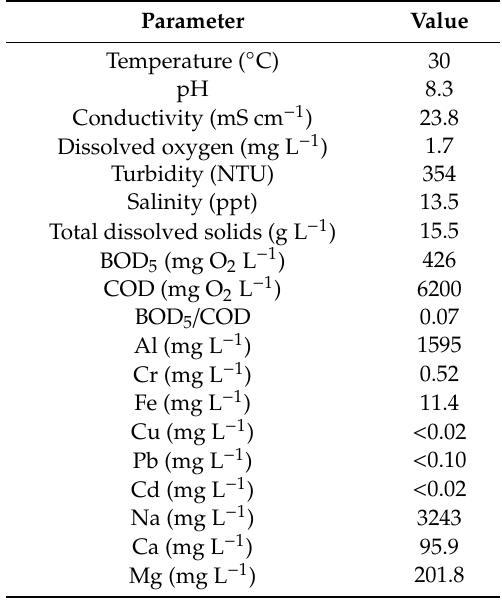
Figure 1. Ubication of the municipal sanitary landfill. Table 1. Physicochemical properties of landfill leachate.